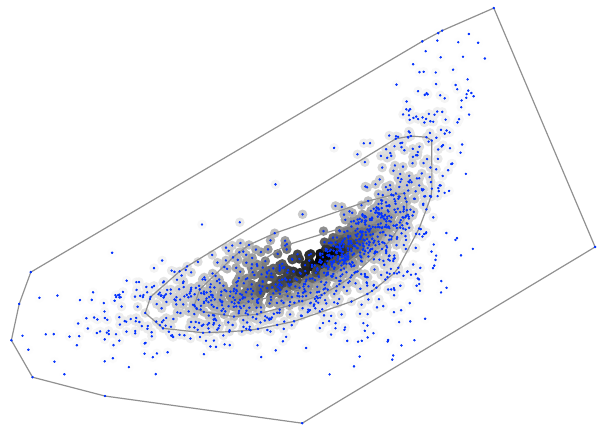
Fig. 1: 2 -dimensional point set shaded according to assigned Fig. 1. 2-dimensional point set shaded according to assigned depth. depth. A darker point represents higher depth. The lines in- A darker point represents higher depth. The lines indicate convex dicate convex hulls enclosing the 25%, 50%, 75% and 100% hulls enclosing the 25%, 50%, 75% and 100% deepest points. The deepest points. The used depth function was halfspace depth. used depth function was halfspace